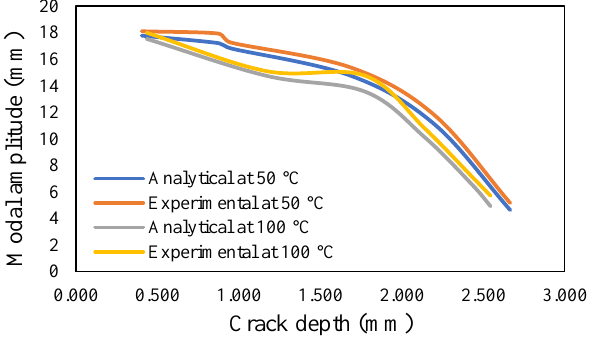
Figure 34. Comparison of the modal amplitude of the propagated crack at an isothermal temperature of 50 and 100 °C.